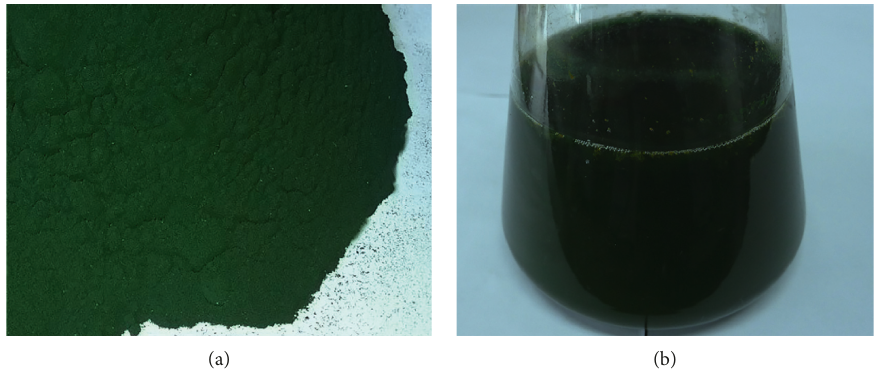
Figure 1: Spirulina sp. powder and cultured Spirulina